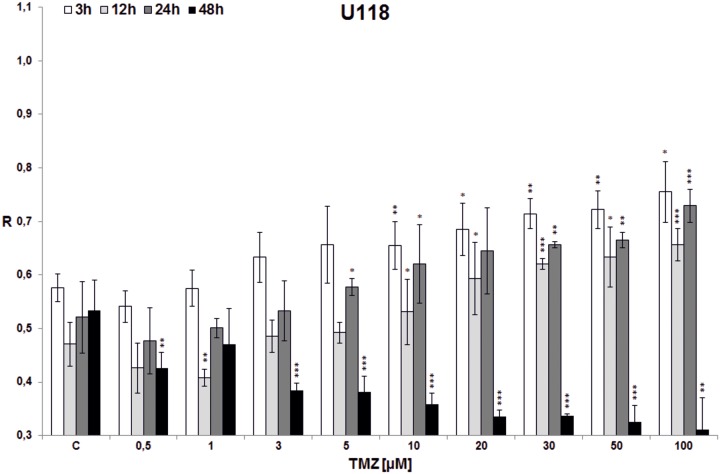
The effect of TMZ on total DNA methylation of U118 cell line.The analysis was performed after 3 (white bars), 12 (light grey bars), 24 (dark grey bars) and 48 (black bars) hrs of incubation in a given TMZ concentration (0.5–100 μM). Control cells (C) were treated with DMSO only. The R values are means from three experiments ±SD. Asterisks indicate a significant difference (*p < 0,05, **p < 0,01, ***p < 0,001) from the control (DMSO) value. Significant demethylating tendency is seen with 48 hrs incubation time in all TMZ concentrations. The TMZ amount needed to reach hypermethylating effect depends on incubation time and is within the range 1–10 μM.